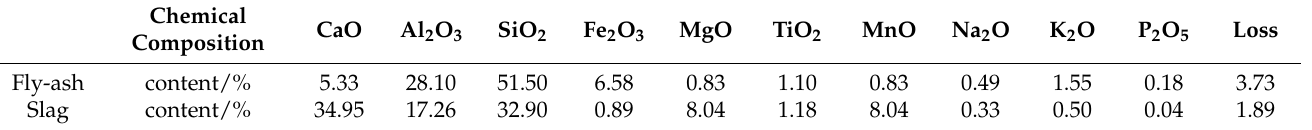
Table 1. Chemical composition of fly ash and slag.